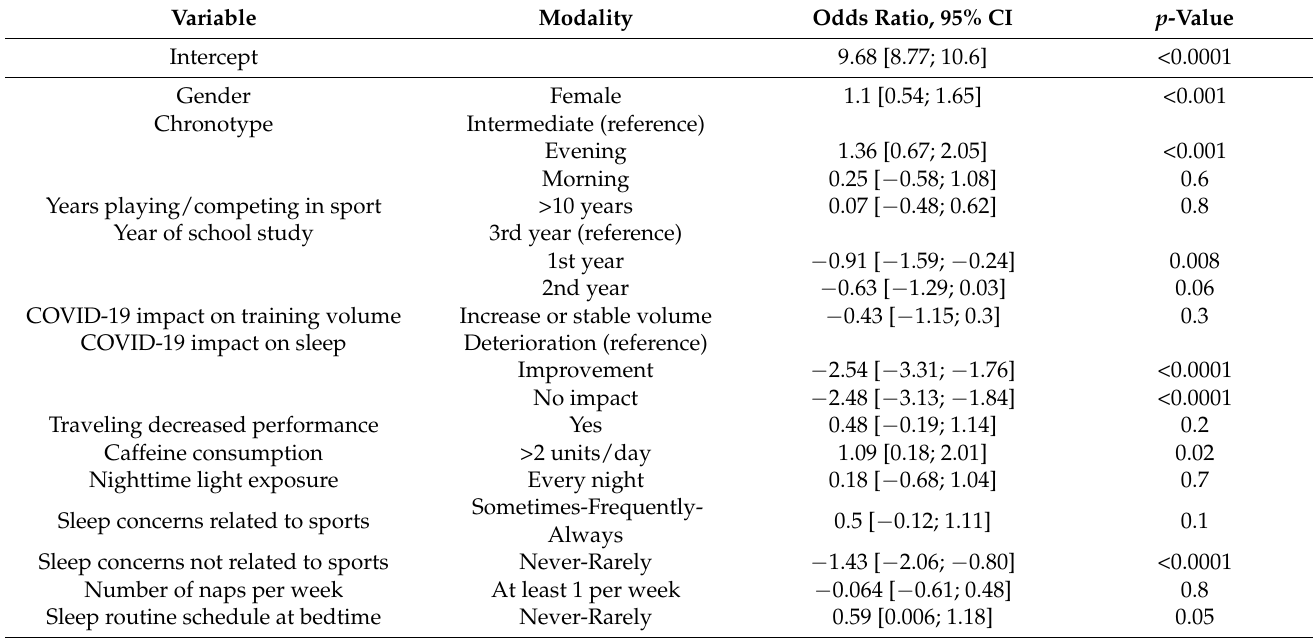
Table 4. Multivariate analysis of PSQI as dependent